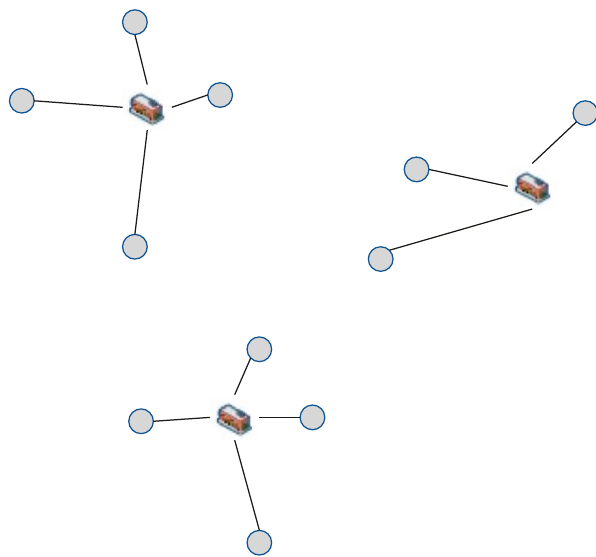
Figure 7: Distribution center identification and neighborhood